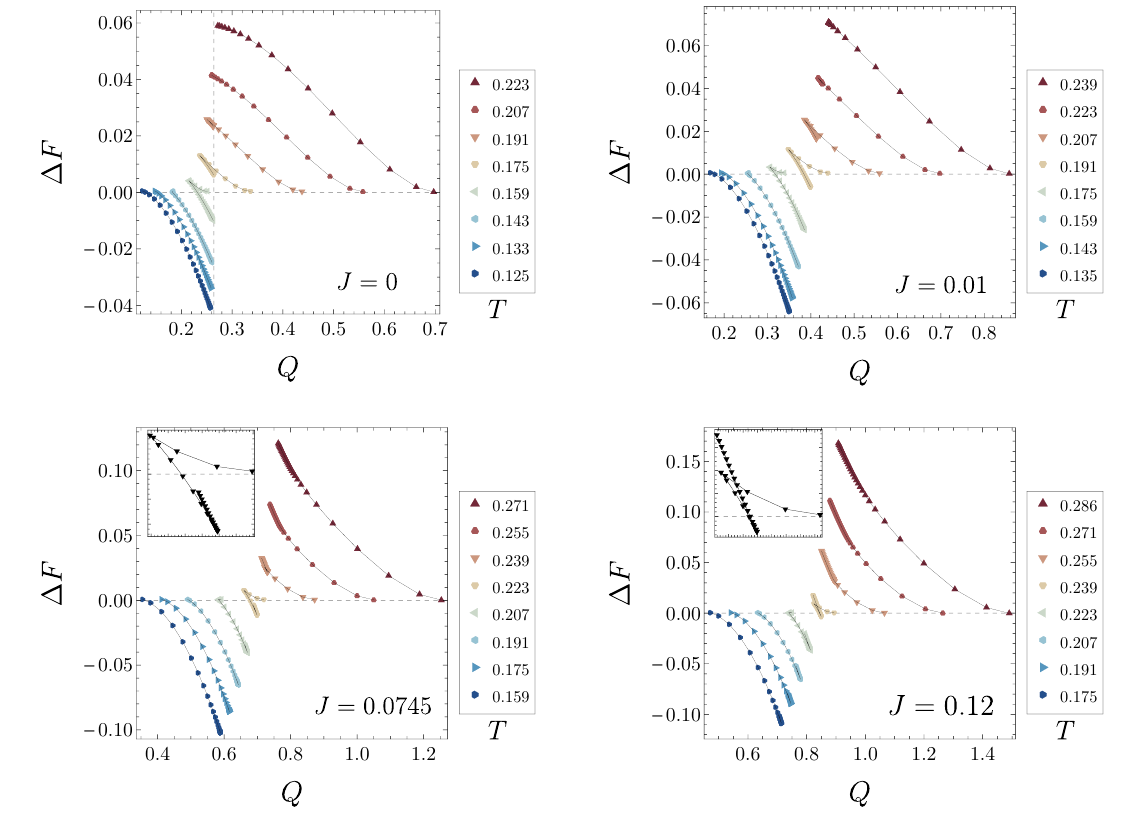
Figure 17 . Di(cid:11)erence in the Helmholtz free energy (cid:1) F = F (cid:0) F CLP , where F CLP is the free energy for the corresponding CLP black hole with the same angular momentum J , temperature T and charge Q . Here " H (cid:20) 15, and the dashed vertical gridline for J = 0 correspond to the critical charge Q c ’ 0 : 26. In general the isotherms demonstrate a complicated behaviour, exhibiting cusp and swallowtail type phase transitions. For all hairy black holes F > 0 with respect to the thermal